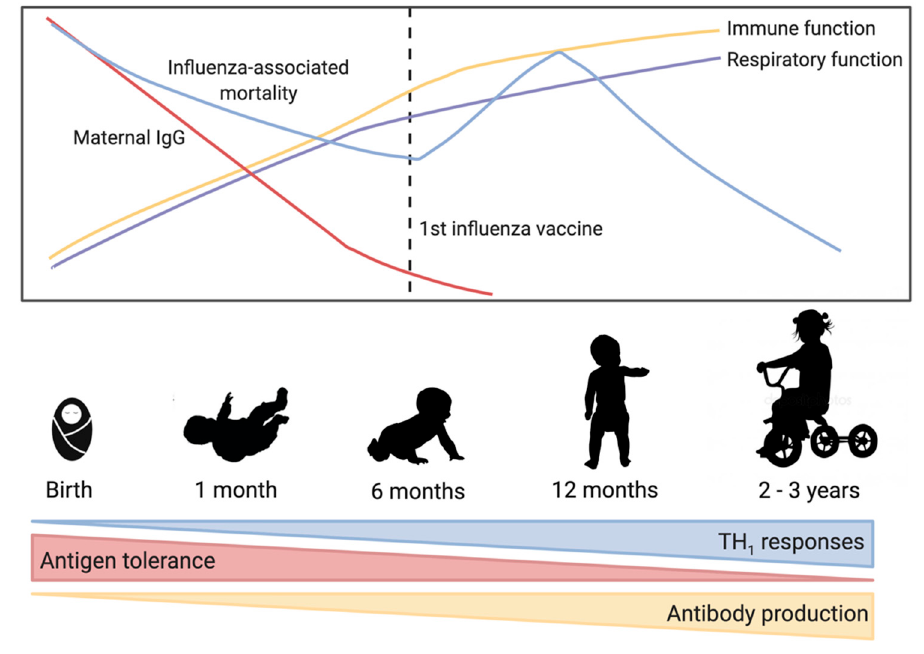
Figure 1. Trends in early-life immune development and influenza virus-associated mortality. As immune and respiratory function improve over the first few years, influenza-associated mortality decreases. Maternal immunoglobulin G (IgG) is high in full term babies but then decreases rapidly over the first few months of life. At birth, the immune system is biased toward T helper cell type 2 responses, but maturation over the first 2–3 years of life is characterized by increased T helper cell type 1 responses and increased antibody production allowing a balanced response to